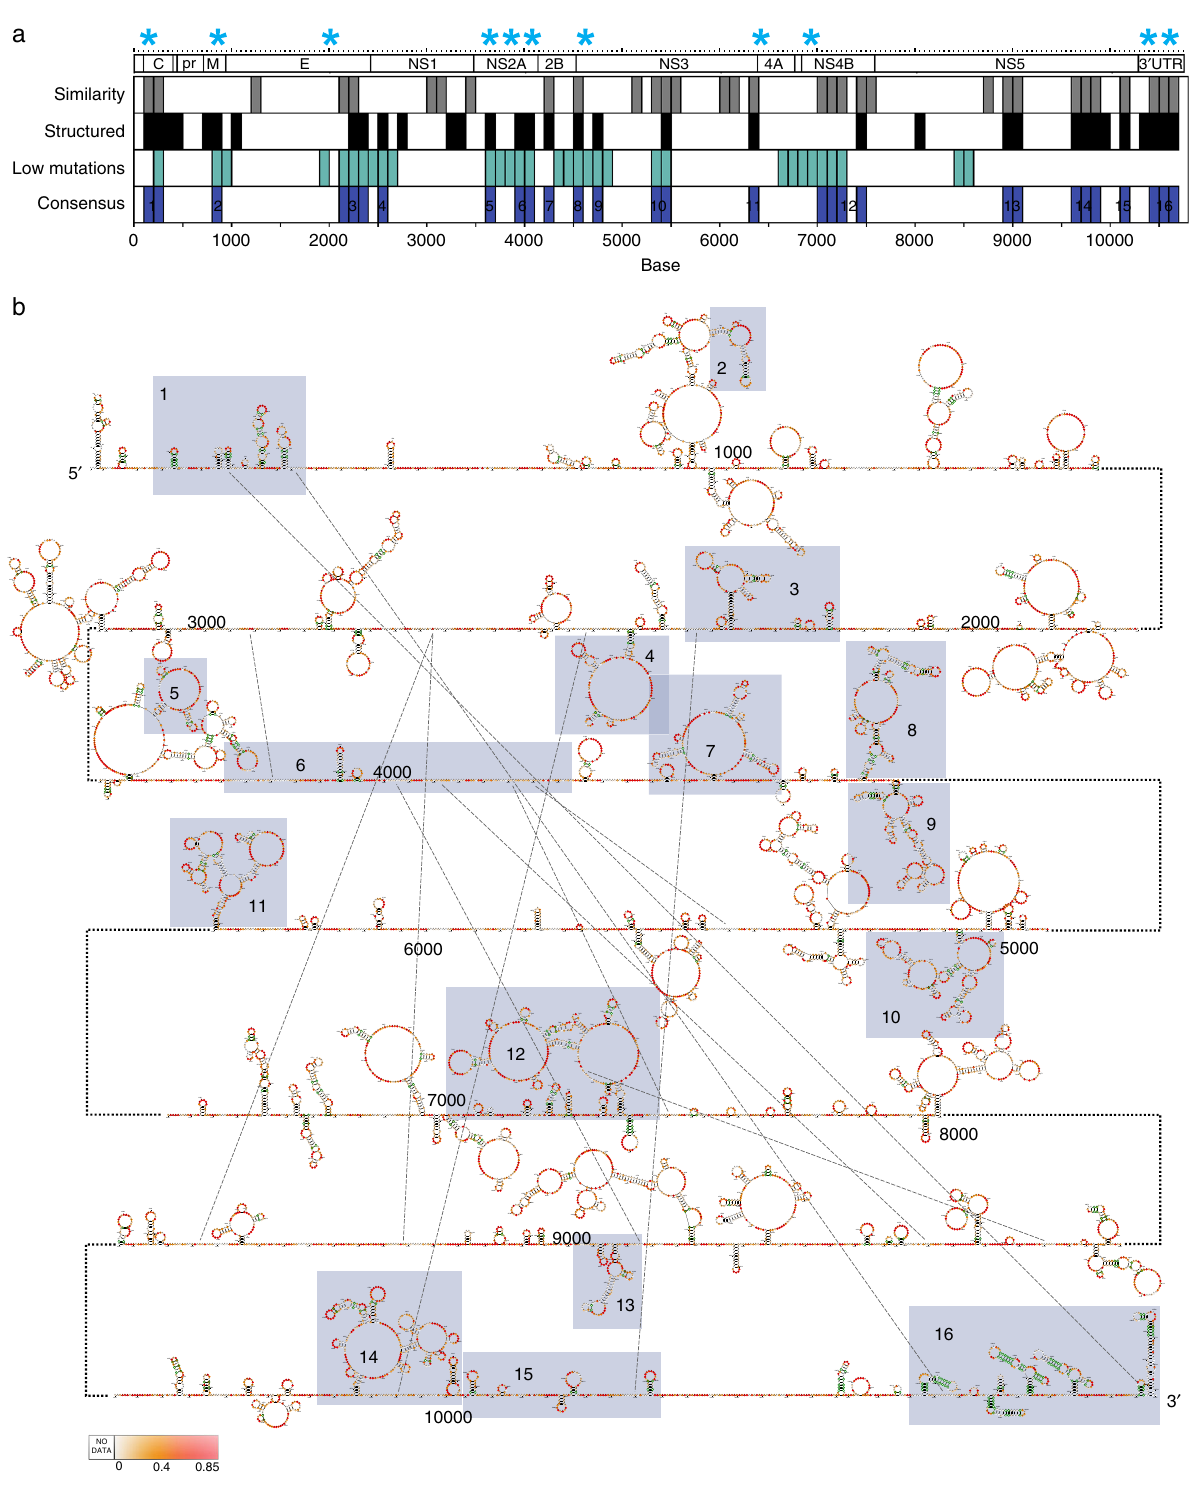
Fig. 2 DENV genome contains many conserved structural elements. a Plots show 100-nucleotide regions across four DENV genomes that have highly similar structures (gray), are highly double-stranded (black), and accumulate low levels of synonymous mutations (blue). Regions that ful fi ll two out of three of the above criteria are selected as consensus regions (purple) and are potentially functionally important. The structurally conserved regions from Fig. 1e are starred in blue. b A structure model of the DENV1 genome using NAI-MaP as experimental constraints, for the 16 consensus regions identi fi ed in a . The NAI-MaP reactivities and covariation information (green circles) are mapped onto the